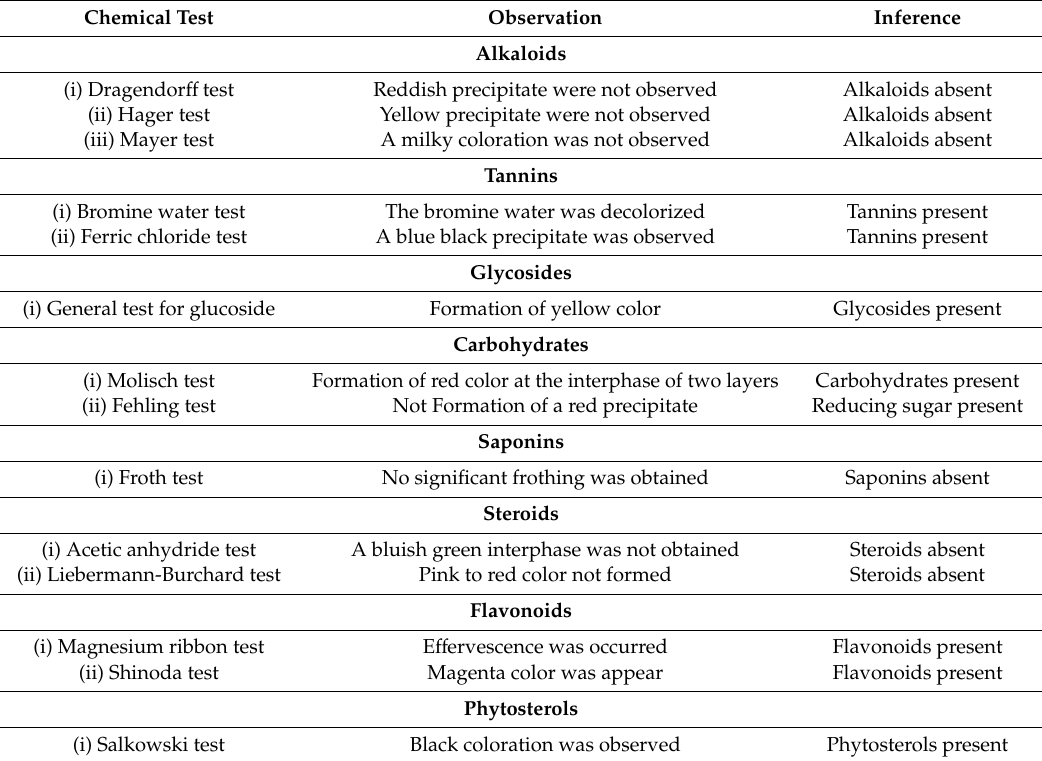
Table 1. Phytochemical screening of the methanolic extract of Punica granatum leaves.